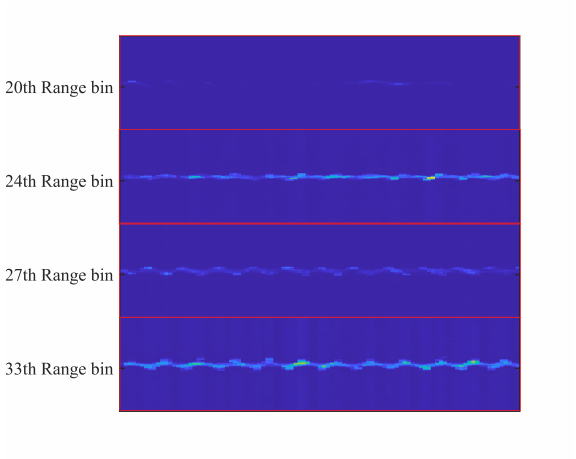
Figure 7. Range–Doppler feature overlay